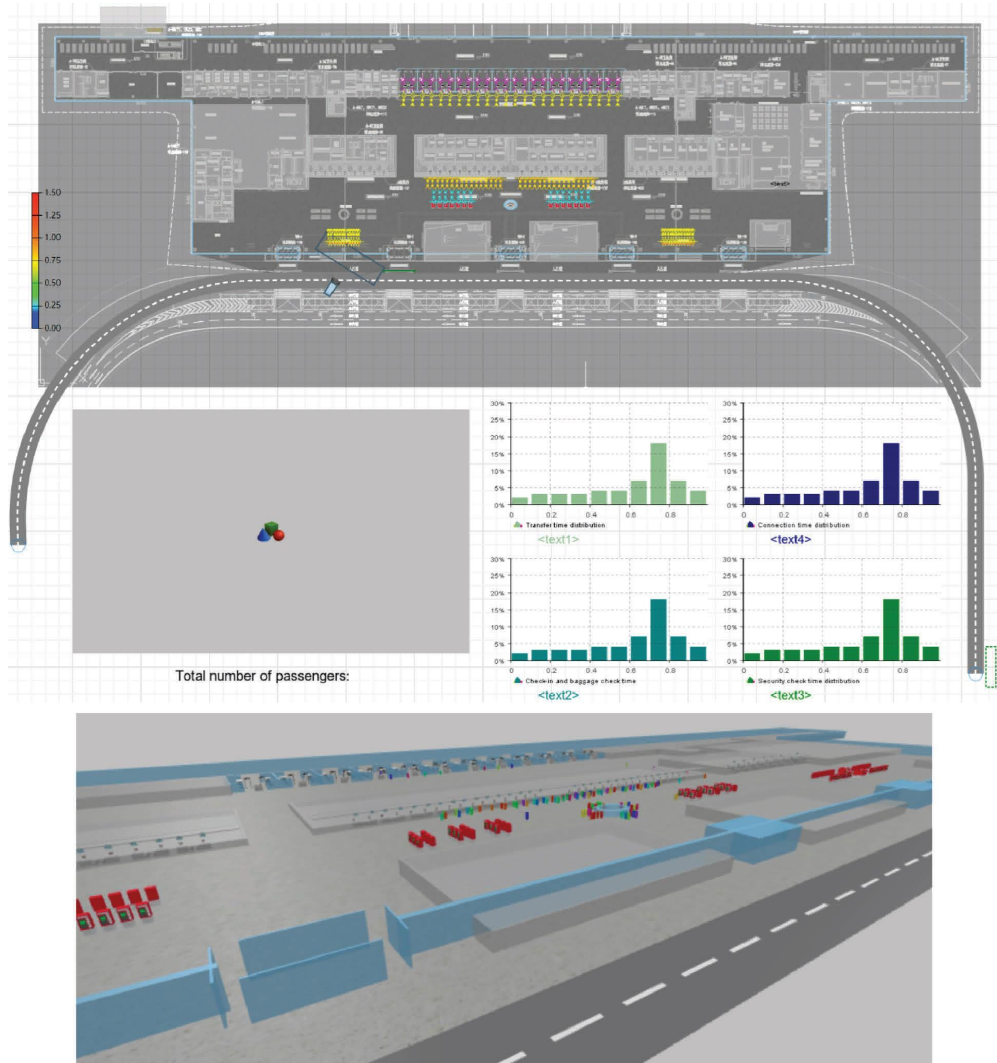
Figure 6: Environment modelling of Zhengding International